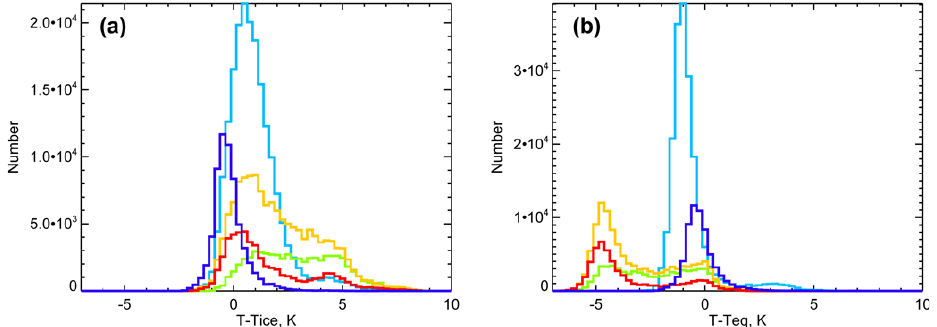
Fig. 7. Histograms of CALIOP PSC observations at 490K potential temperature during 1 December 2009–31 January 2010 as a function of (a) T − T ice and (b) T − T eq by composition: STS (light blue), Mix 1 (green), Mix 2 (orange), Mix 2-enh (red), and ice (dark